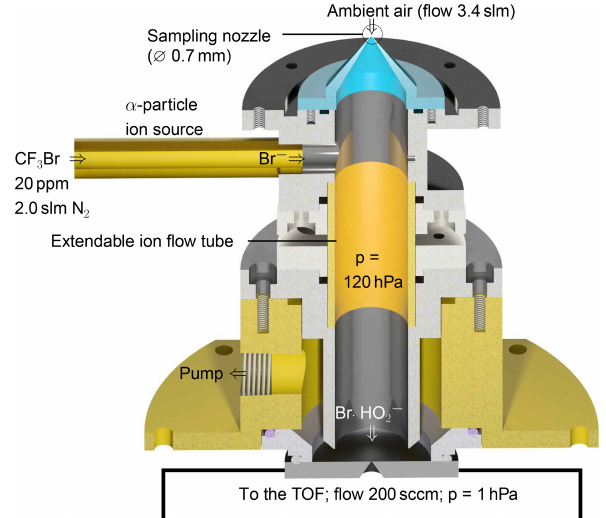
Figure 1. Schematic drawing of the ion flow tube, where HO 2 clus- ters with Br − are formed. The ion flow tube is mounted upstream of an Aerodyne time-of-flight mass